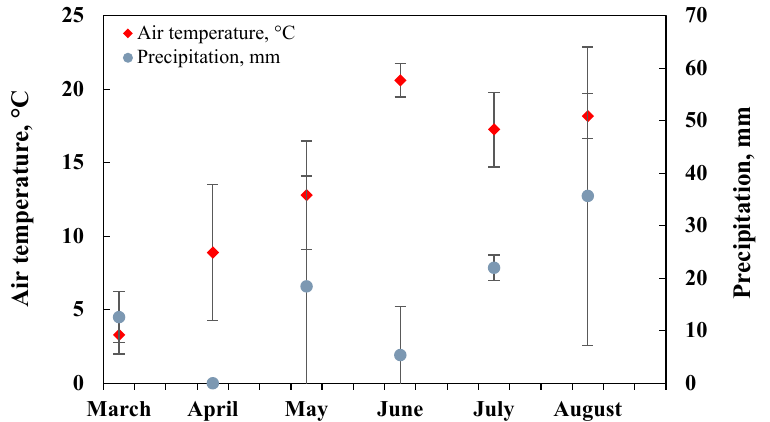
Figure 1. Average monthly temperature (°C) and amount of precipitation (mm) according to every month 10-day data from Dotnuva meteorological station, n = 3.